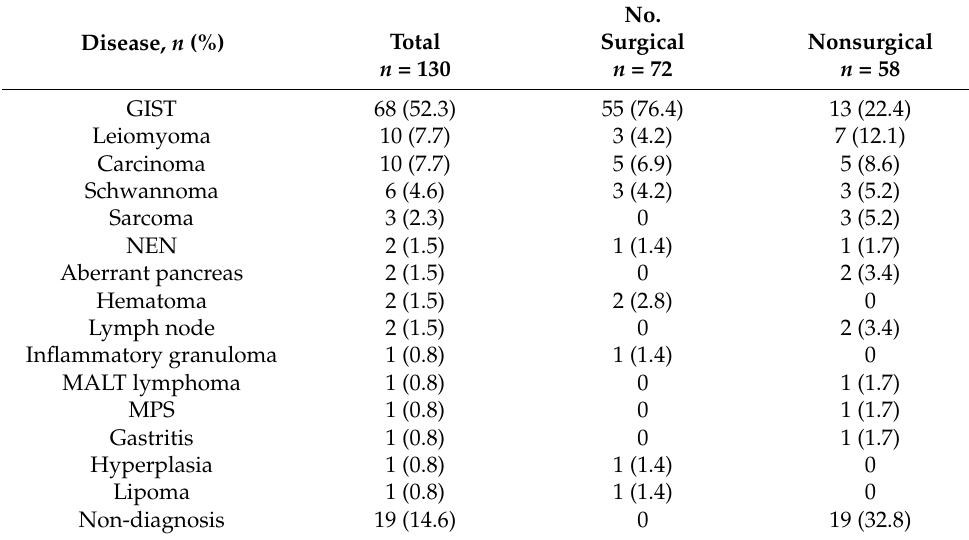
Table 2. Details of final diagnosis of all SELs ( n =